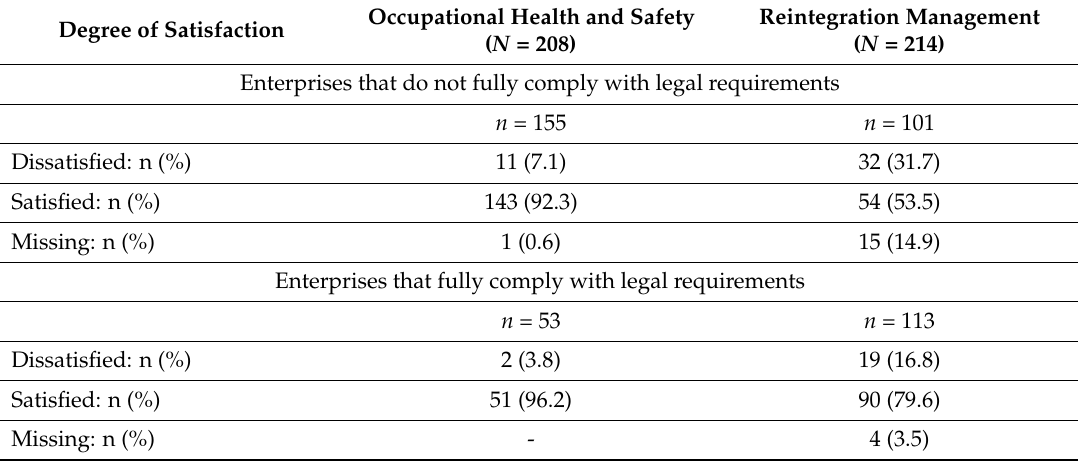
Explication of Table 6: For the sake of clarity, the response categories ‘very dissatisfied’ and ’rather dissatisfied’ were combined to form the ‘dissatisfied’ category, while the response categories ‘very satisfied’ and ‘rather satisfied’ were combined to form the ‘satisfied’